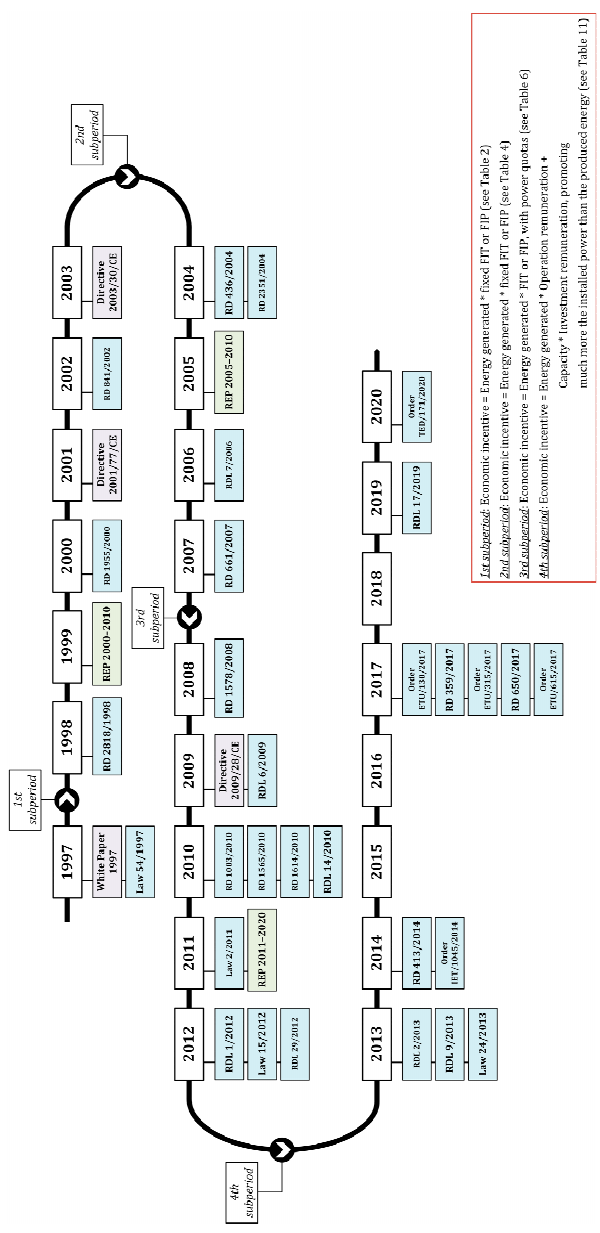
Figure 3. Timeline with the different legislations governing the Spanish solar power sector from 1998 to 2020. Source: self-elaboration.